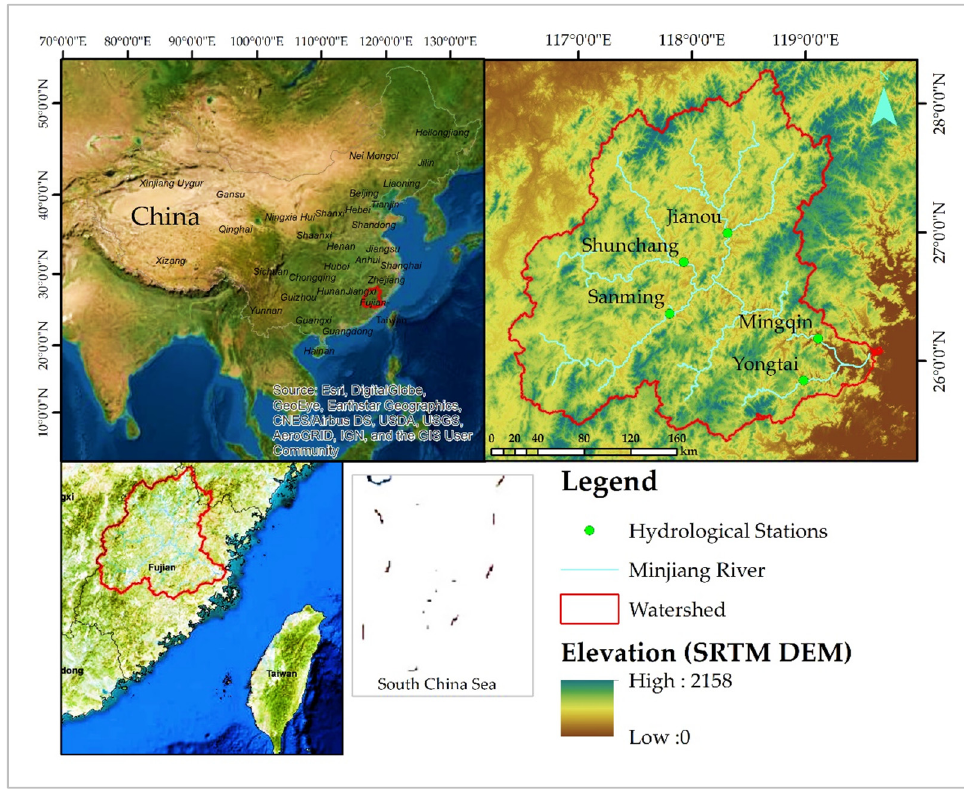
Figure 1. Location of the Minjiang river, its main tributaries, watershed, and hydrological stations.